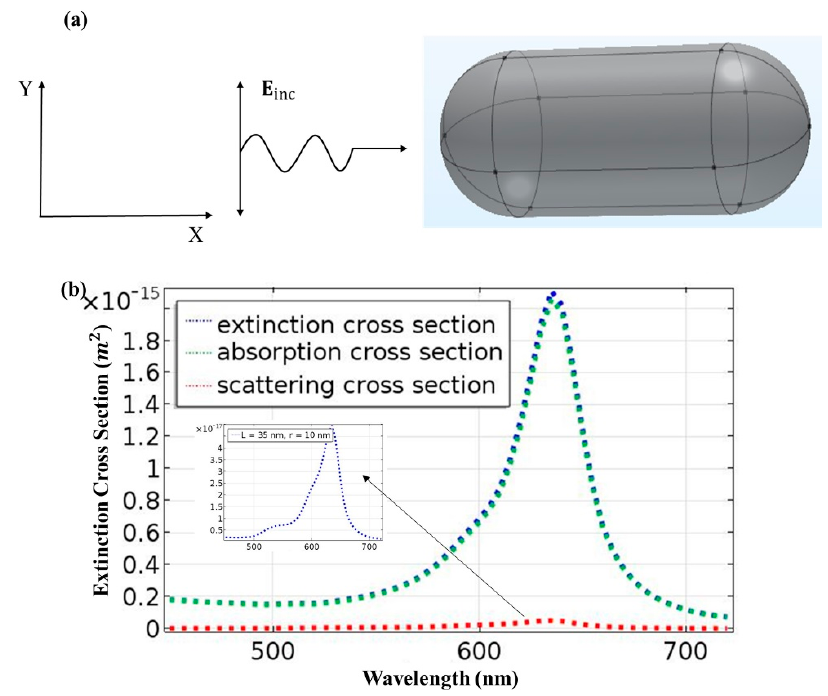
Figure 1. ( a ) Schematic of interaction of an electromagnetic wave with a gold nanorod and ( b ) extinction cross-section of AuNR at λ = 635 nm, length = 35 nm and r = 10 nm.